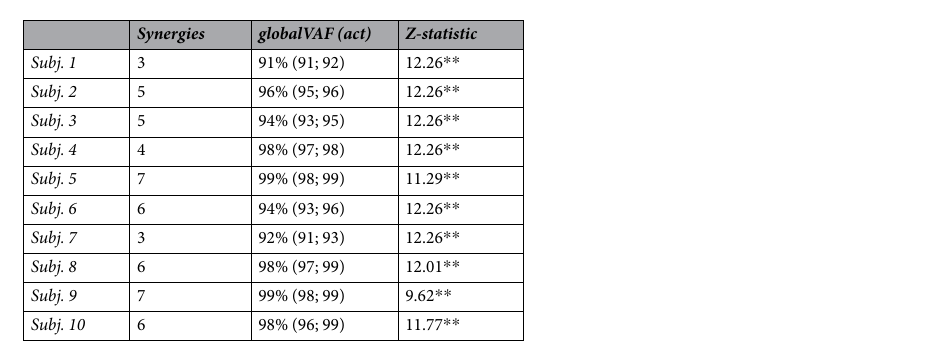
Fig. S2 in Supplementary Material). The comparison of variance accounted for (VAF) by the real EMG data- set and structure-less data (see Muscle synergy extraction , Methods section) supports the reliability of our anal-